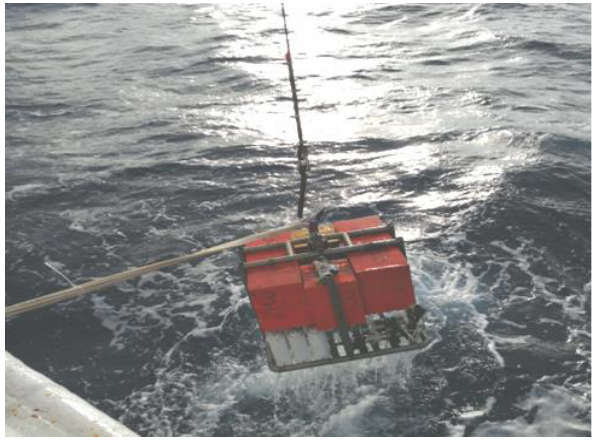
Figure 17. The recovery process of the benthic lander.